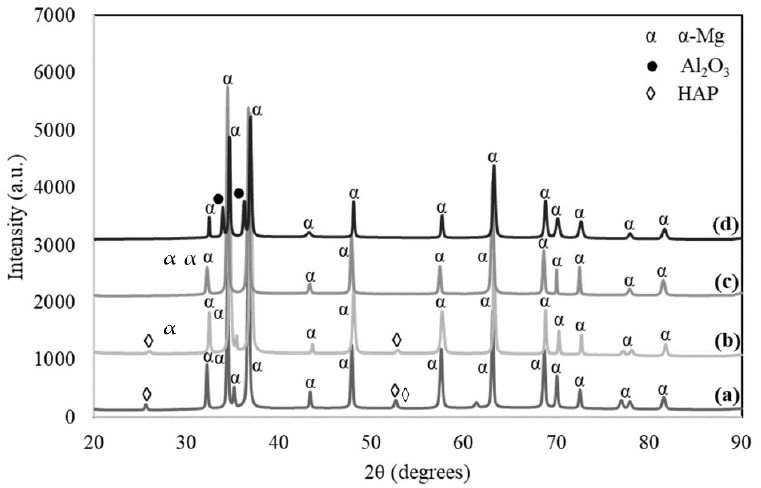
Figure 2. XRD pattern of Mg-Zn/HAP/Al 2 O 3 composites with different amount of HAP and Al 2 O 3 ( a ) 0 wt.% Al 2 O 3 , ( b ) 5 wt.% Al 2 O 3 , ( c ) 10 wt.% Al 2 O 3 and ( d ) 15 wt.% Al 2 O 3 .